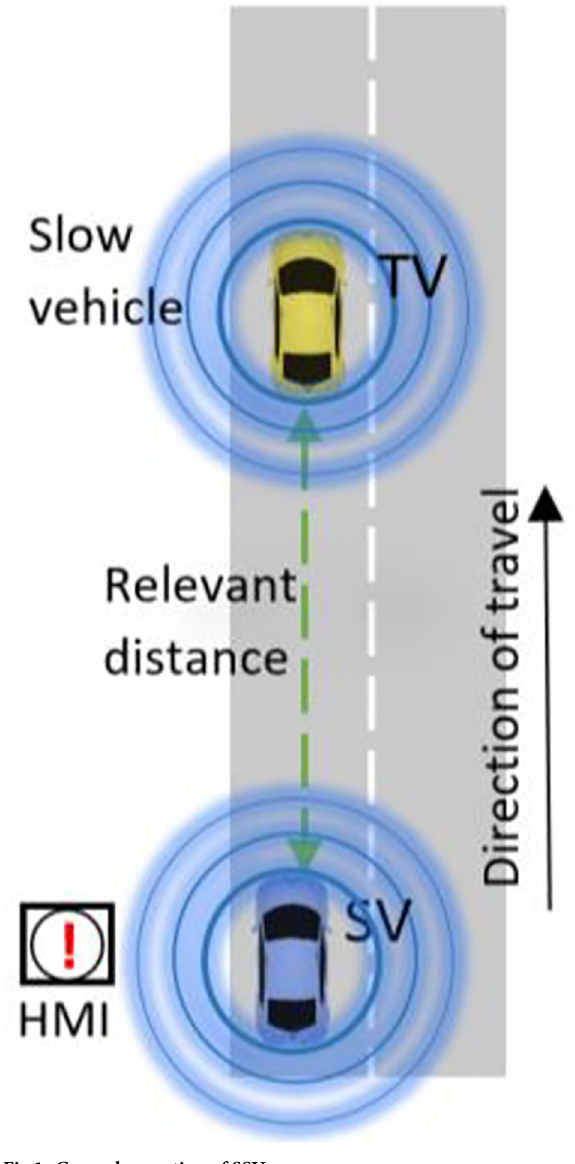
Fig 1. General operation of